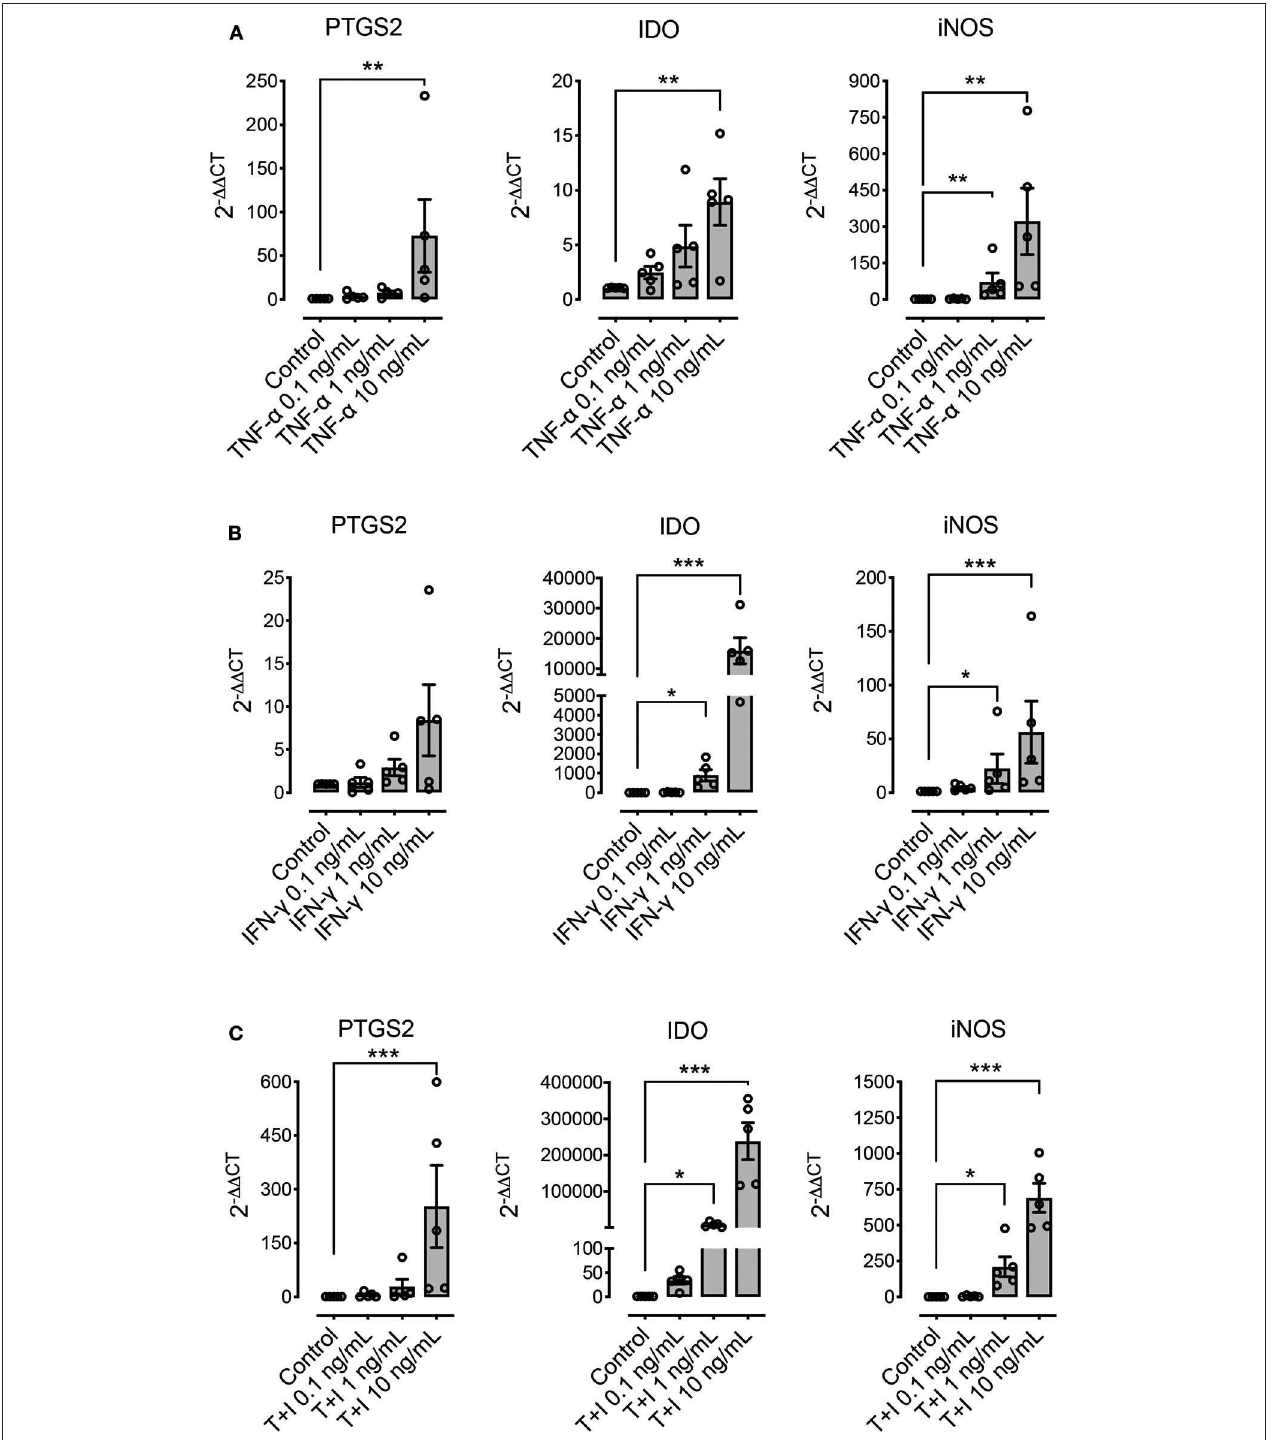
FIGURE 4 | Pre-conditioning increases the expression of immunomodulatory genes in MSCs. The effect of pre-conditioning equine bone marrow-derived MSCs during 24h with TNF- α (A) , IFN- γ (B) or its combination (C) on the expression of prostaglandin-endoperoxide synthase 2 (PTGS2), indoleamine 2, 3 dioxigenase (IDO), and inducible nitric oxide synthase (iNOS) (* p < 0.05, ** p < 0.01, *** p < 0.001; n = 5).